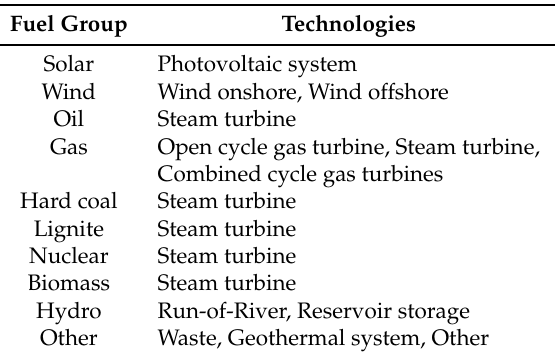
Table 1. Overview of fuel groups and